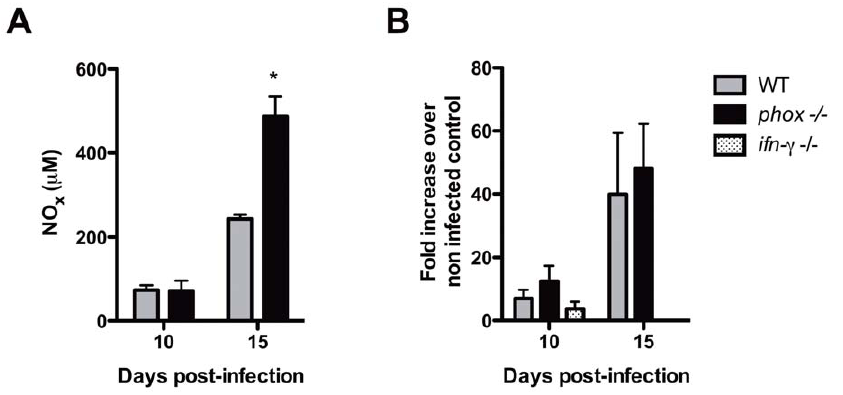
Figure 4. Augmented NOx levels in phox KO mice infected with T.cruzi , when compared to WT. (A) T. cruzi -infected mice were bled at 10 and 15 days post-infection and levels of nitrate and nitrite evaluated. Bars represent mean 6 SE of 4 animals per group. Asterisks indicate P , 0.05 by Student’s t test. (B) Spleens from infected animals were harvested at 10 and 15 days post-infection and used for RNA extraction and real-time RT-PCR as described in material and methods. NOS2 expression was evaluated after normalization with HPRT constitutive gene.